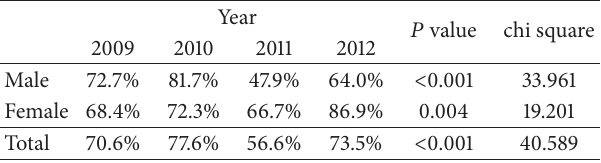
Table 2: The E. coli resistance to Trimethoprim-sulfamethoxazole over the study